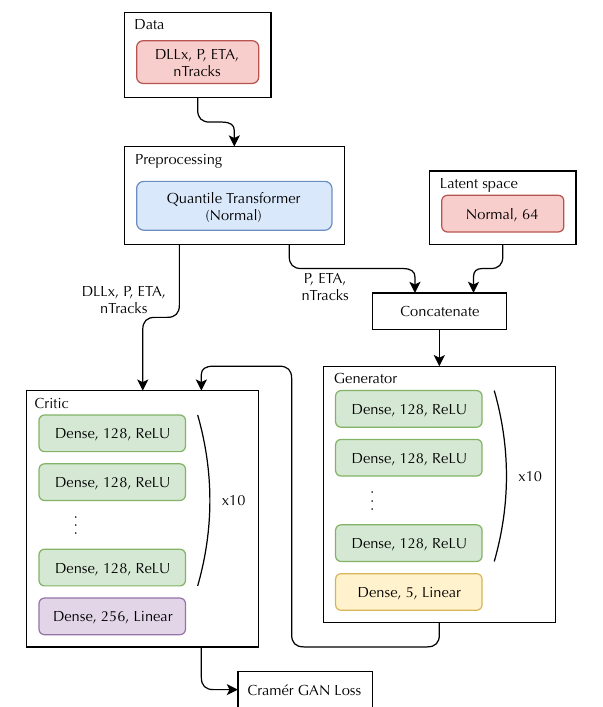
Figure 4: RICH GAN model architecture. Generator is trained to produce five particle iden- tification responses for the RICH detector for three input parameters: particle momentum, pseudorapidity, and the total event track